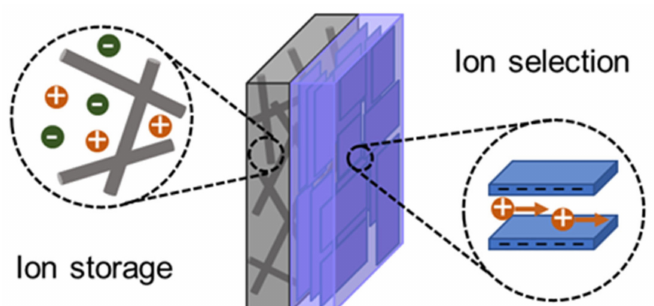
Figure 5. Schematic of the GO–CA membrane structure. The CA membrane and GO membrane serve as ion storage layer and ion selection layer,